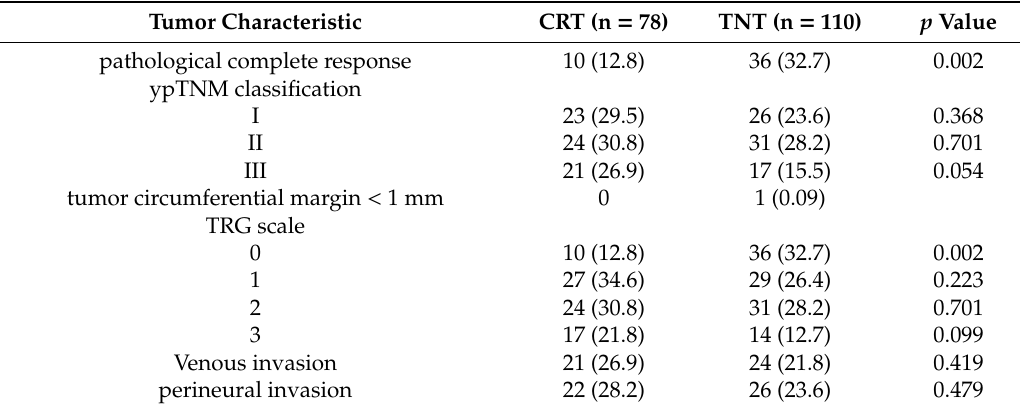
Table 3. Pathologic Examination of Resected